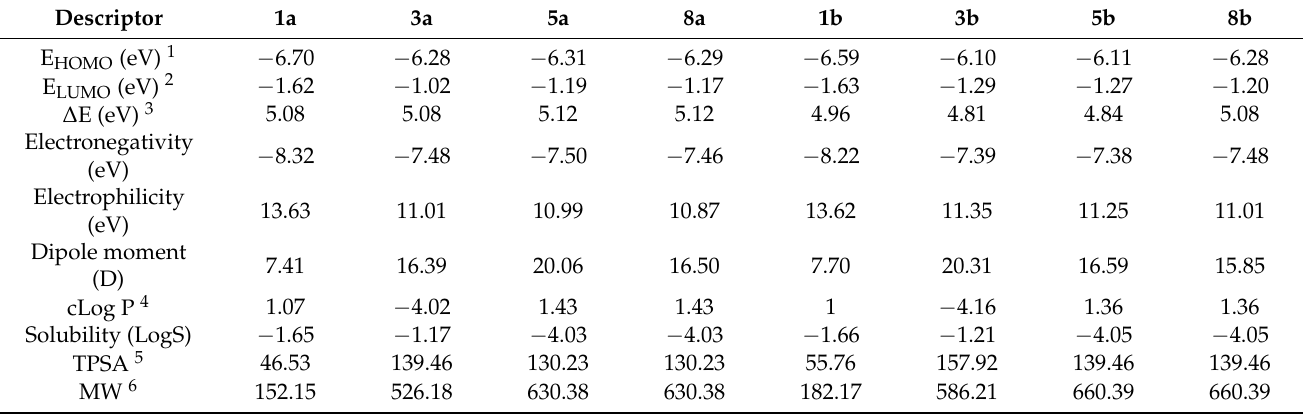
Table 2. Molecular descriptors obtained for phenolic acids and their conjugates with